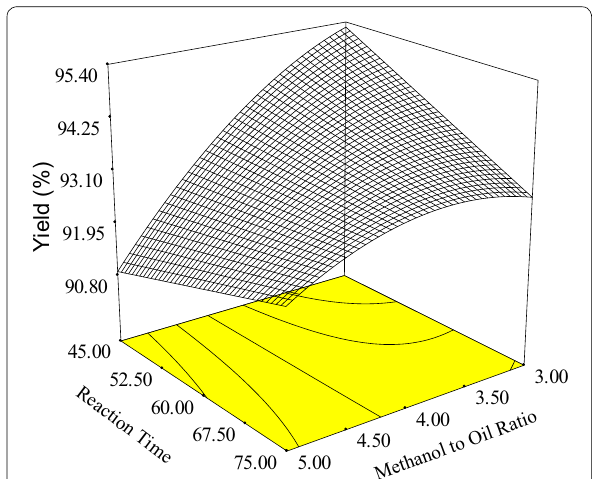
Fig. 5 3D plot of the effects of methanol–oil ratio and time to FAME yield